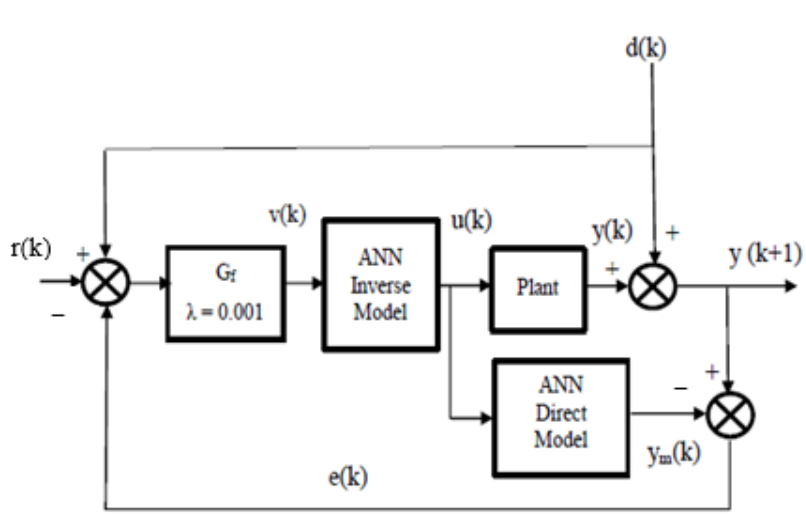
Figure 11. Modified IMC Neural Network block diagram .